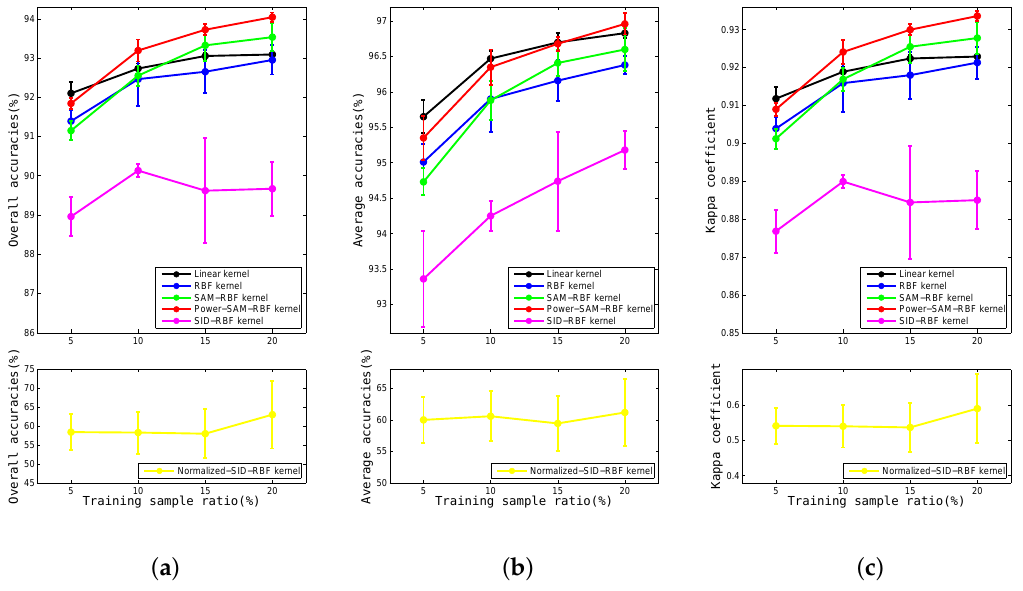
Figure 10. Curves of ( a )OA, ( b )AA, and( c ) kappa coefficient for the Linear, RBF, SAM-RBF, Power- SAM-RBF, SID-RBF, and Normalized-SID-RBF kernels with proportions of training data of 5%, 10%, 15%, and 20% for the Salinas Valley